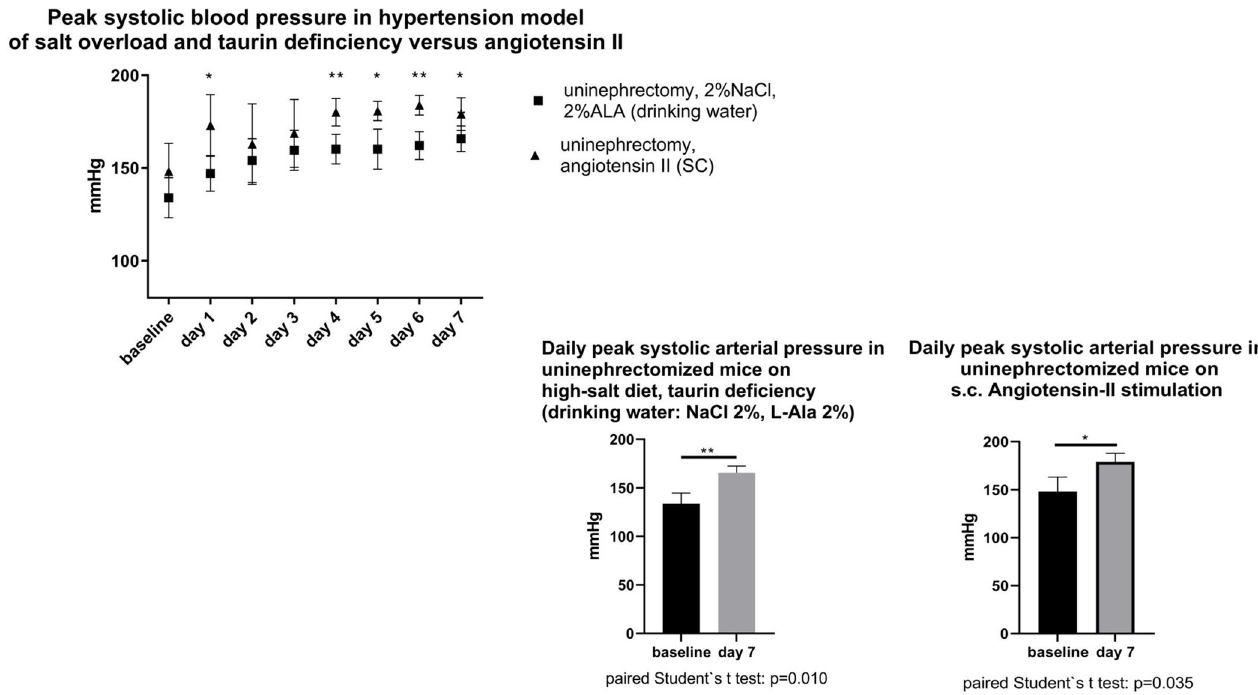
Fig 4. Upper panel: evolution of daily peak systolic blood pressure in uninephrectomized mice during hypertension-inducing interventions. a) oral sodium-chloride load and taurine deficiency (NaCl (2%) + L- alanine (2%)-enriched drinking water); b) angiotensin II: 1.4 mg/kg/d subcutaneously applied by osmotic minipump. Lower panel: direct comparison of daily mean systolic blood pressure within groups (baseline versus end of study).